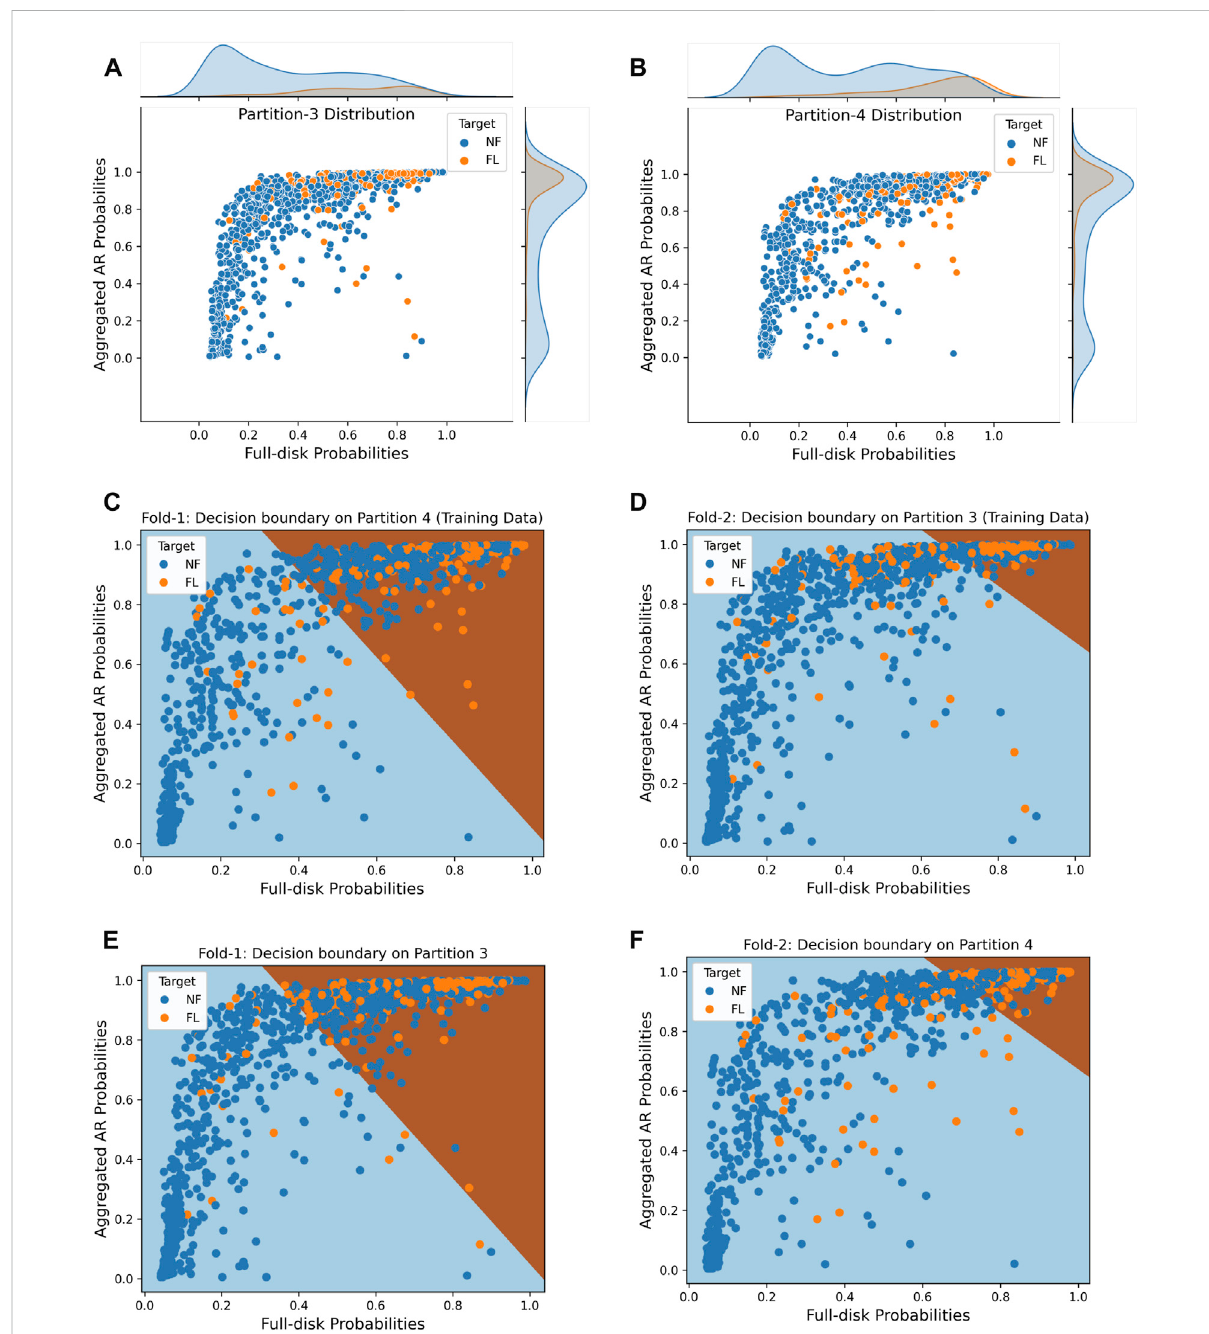
FIGURE 8 The fi gure shows the distribution of predicted probability scores for all the data instances used in Experiment-1 and the decision boundary learned by the trained logistic regression classi fi er for both the partitions: (A) Distribution of probabilities scores in partition-3 of two base learner mappingto actualouput. (B) Distribution ofprobabilitiesscores inpartition-4oftwobaselearnermapping toactualouput. (C) The learned-decision boundary by Meta-FP LR while training on partition-4. (D) The learned-decision boundary by Meta-FP LR while training on partition-3. (E) The learned-decision boundary by Meta-FP LR validated on partition-3. (F) The learned-decision boundary by Meta-FP LR validated on